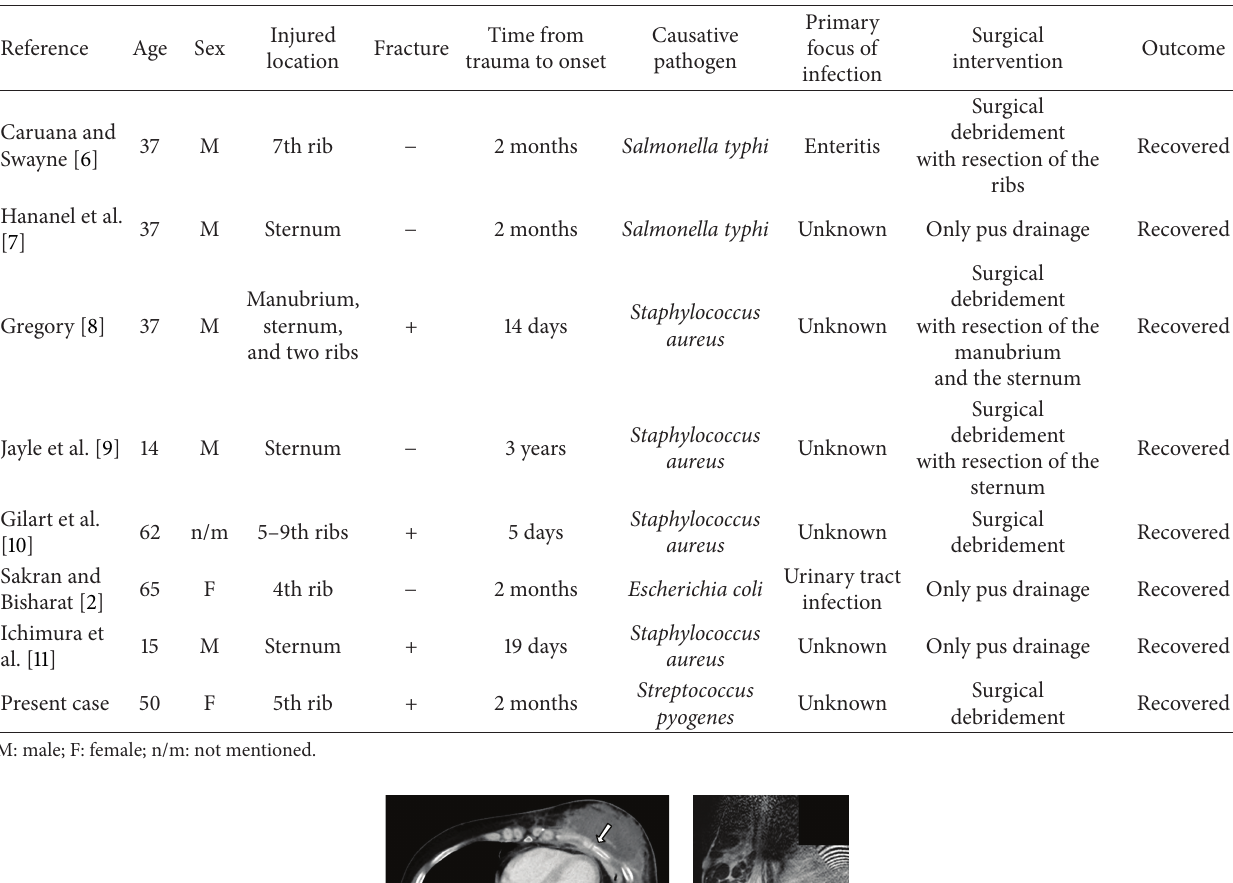
Table 1: Reported cases of primary chest wall abscess occurring after blunt chest trauma.